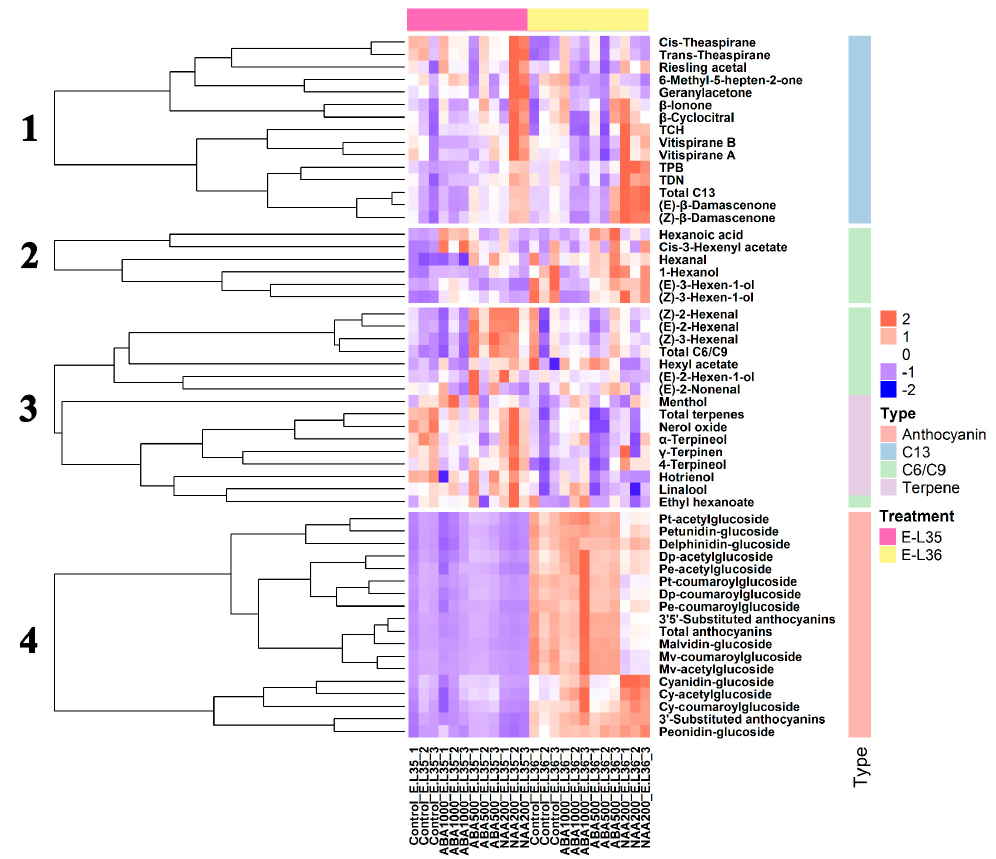
Figure 7. Heatmap analysis and hierarchical clustering of anthocyanins, terpenes, norisoprenoids, and C6/C9 compounds.